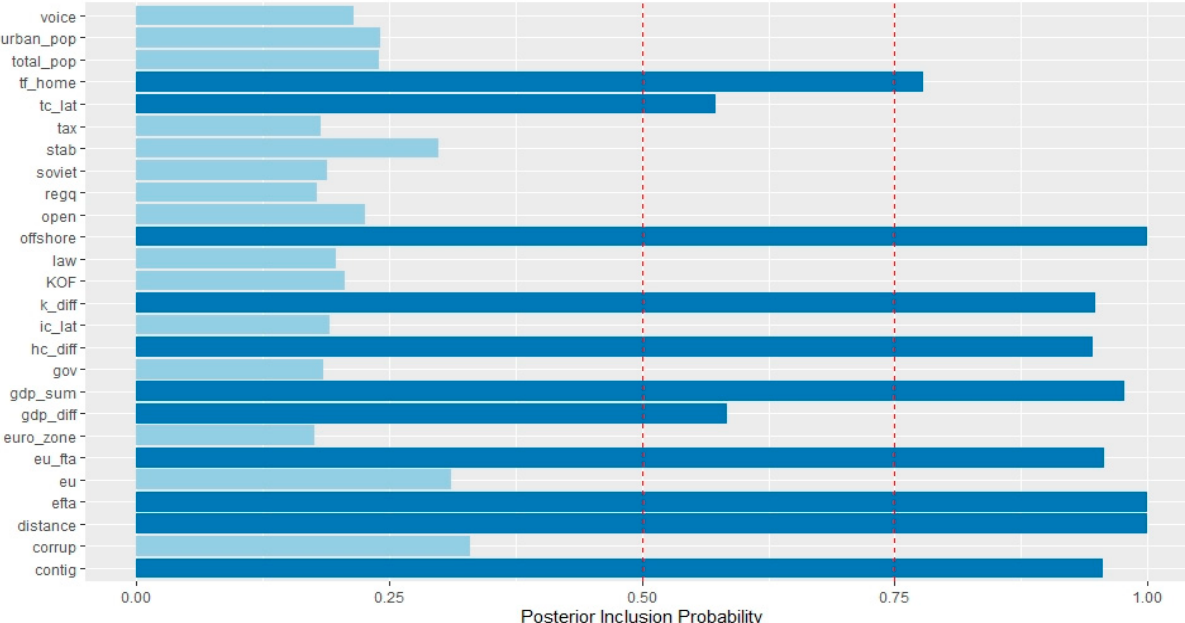
Figure 3. Inclusion probabilities for each of the potential covariates for Latvia, general case (2004–2017).